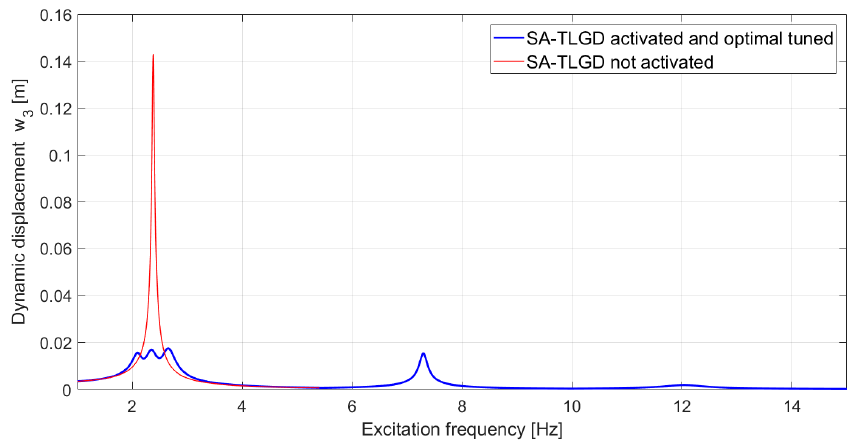
Figure 9. Frequency response functions (FRF) of the force excited MDOF-shear frame structure with and without the two activated optimally tuned SA-TLGDs (steady state response of floor displacement w 3 ).